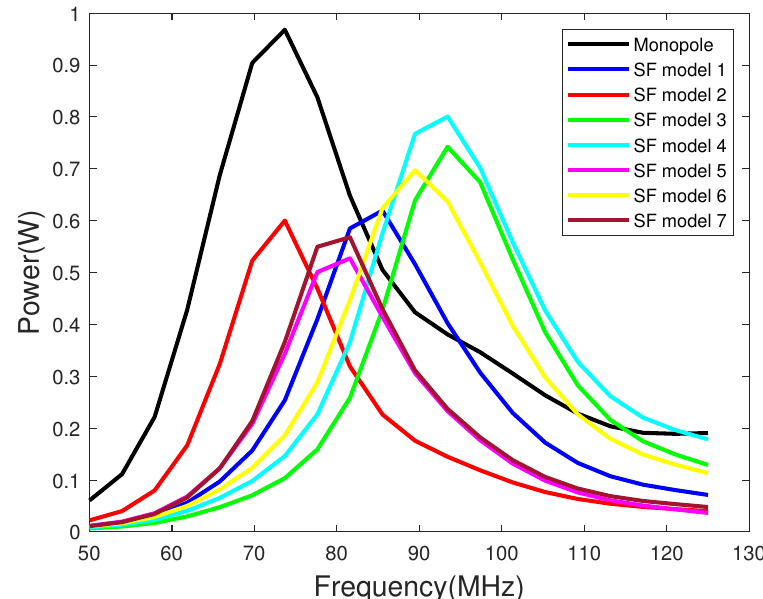
Figure 5. Far-field radiated power vs. the frequency of